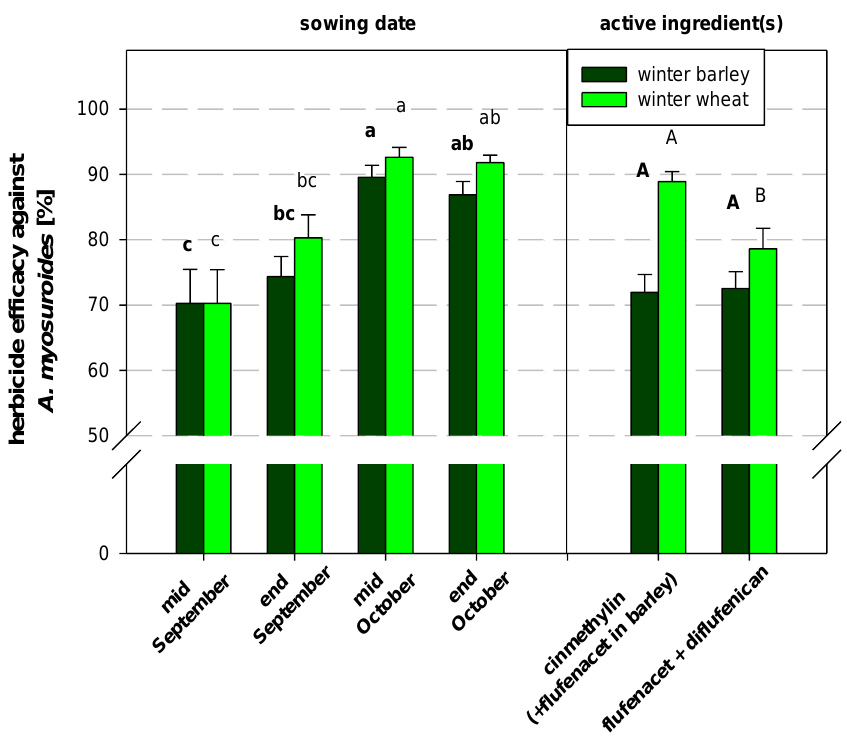
Figure 2. Herbicide efficacy against A. myosuroides [%] in winter barley and winter wheat depending on sowing date and used active ingredient(s) (winter wheat: 500 g cinmethylin ha −1 , winter barley: 250 g cinmethylin ha −1 + 144 g flufenacet ha −1 , both crops: 240 g flufenacet + 120 g diflufenican ha −1 ), error bars represent the standard error, different letters indicate significant differences between sowing date or herbicide treatment (bold letters: winter barley), p ≤ 0.05, Tukey -HSD-Test.